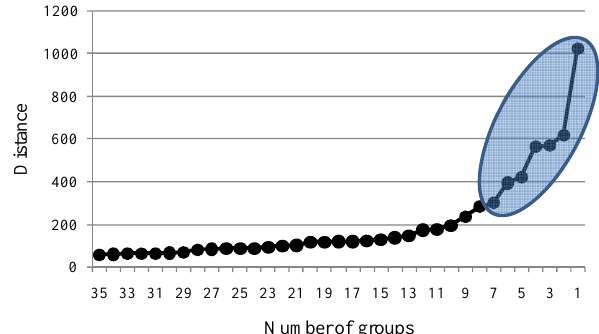
Fig. 5. Scree test of the distance between consecutive coefficients Fig. 5: Scree test of the distance between consecutive coefficients obtained from the 3 obtained from the agglomeration schedule. The shaded area corre- agglomeration schedule. Shaded area corresponds to one significant slope change. 4 sponds to one significant slope change.